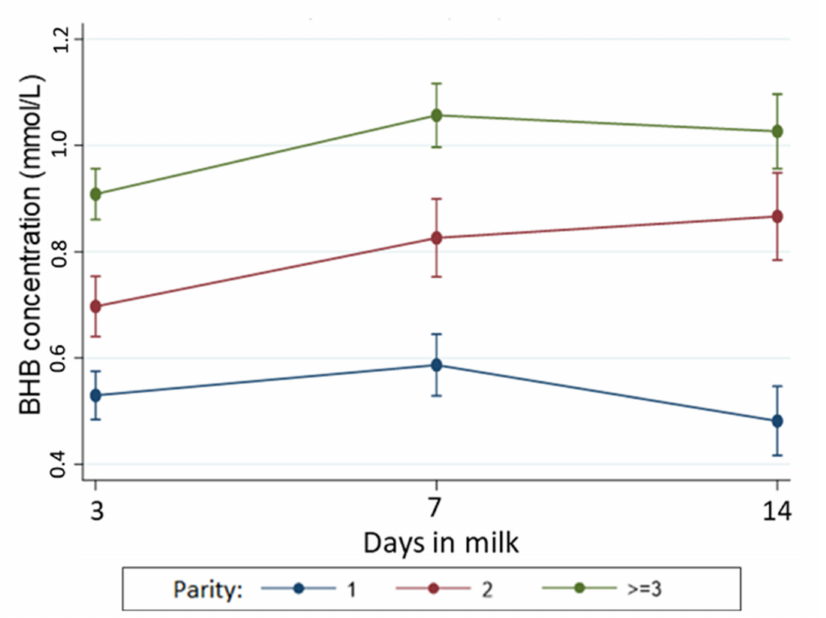
Figure 2. Temporal pattern of BHB concentration (with 95% confidence interval) during early lactation according to parity. The association between BHB concentrations and parity was adjusted in the model by time, BCS at 21 days prepartum, and interaction between parity and time. Number of cows with moderate gain = 130; no-change= 117, moderate loss= 247, and large loss= 65.